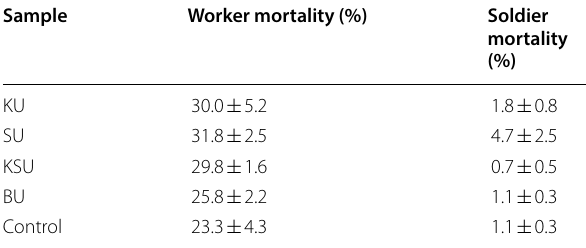
Table 1 Mortalities of workers and soldiers after a 3-week no-choice termite feeding test (mean